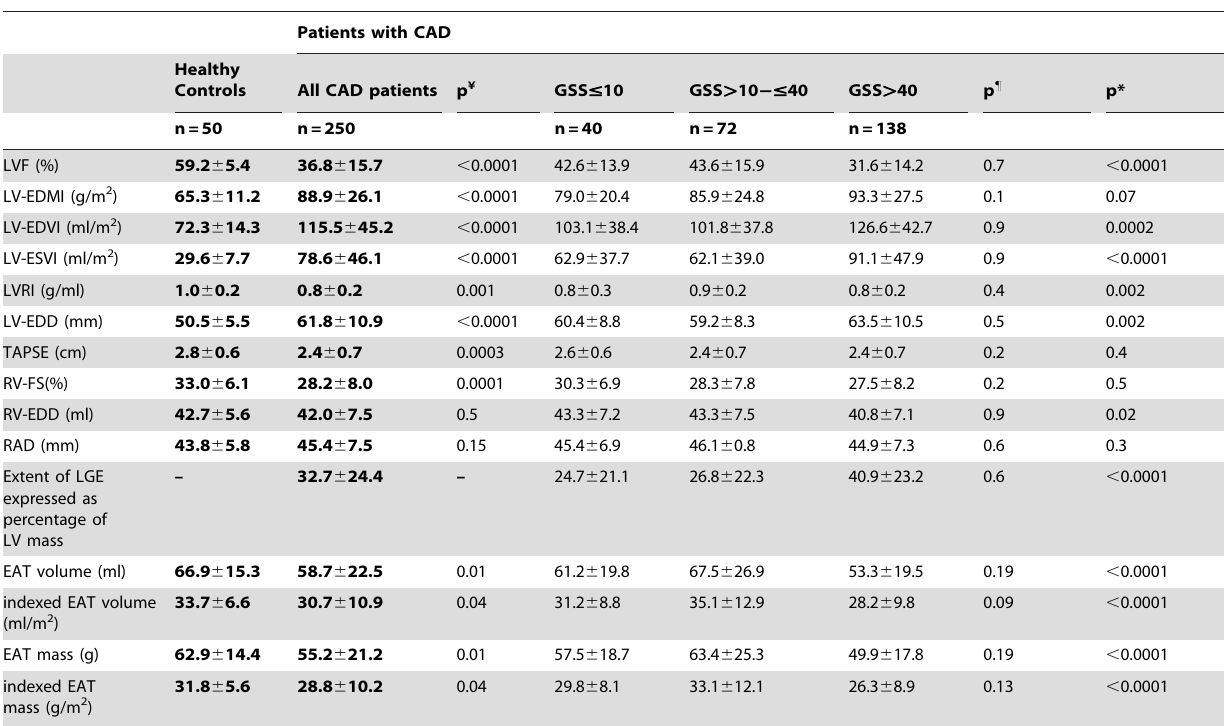
p ¥ =p-value comparing all CAD patients vs healthy controls, p " = p-value comparing CAD patients with GSS # 10 vs CAD patients with GSS . 10 2# 40, p* = p-value comparing CAD patients with GSS . 10 2# 40 vs CAD patients with GSS . 40. Abbreviations: EAT: epicardial adipose tissue , EDD: end-diastolic diameter , EDMI: end-diastolic mass index , EDVI: end-diastolic volume index , ESVI: end-systolic volume index, LV: left ventricular, LVF: left ventricular function , LVRI: left ventricular remodeling index , RAD: right atrial diameter , RV: right ventricular , RV-FS: right ventricular fractioning shortening , TAPSE: tricuspid annular plane systolic excursion.